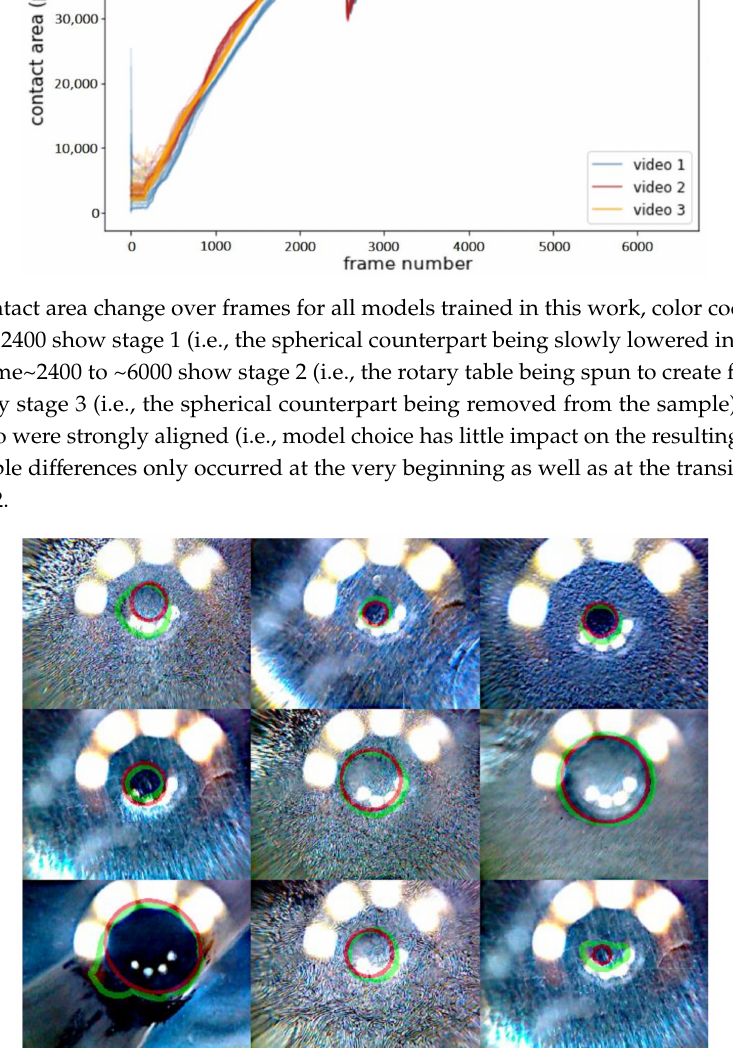
Figure 9. Nine validation samples with the highest loss, when using pre-trained ResNet without pre-processing. Target area is outline in red, predicted area in